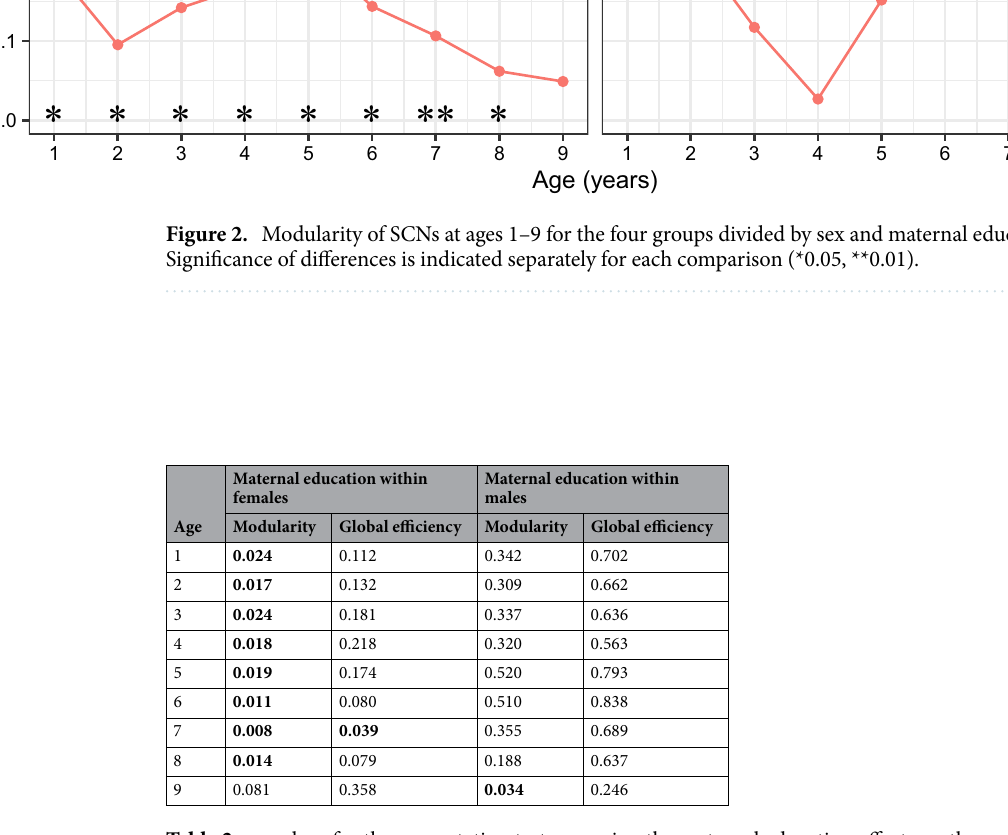
Table 2. p -values for the permutation tests assessing the maternal education effects on the evolution of brain region volumes within females and males based on modularity and global efficiency, where p -values less than 0.05 are emphasized in